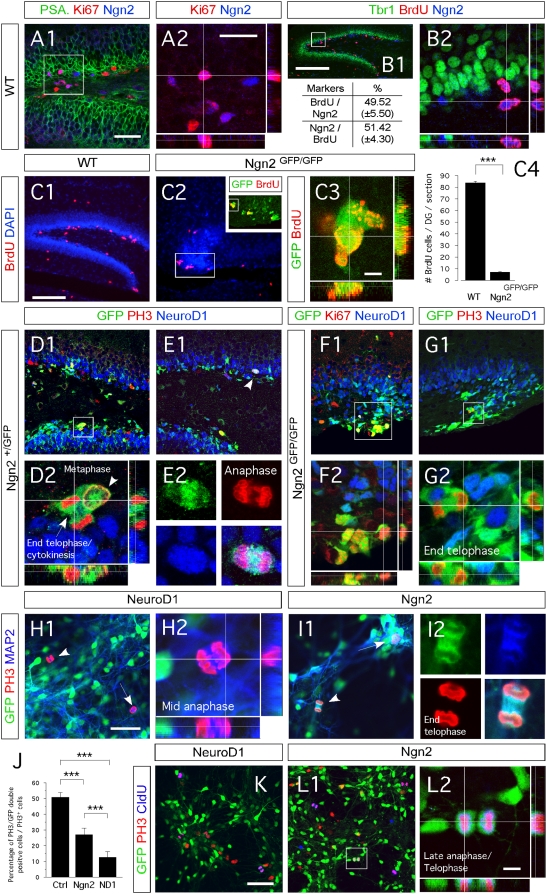
Ngn2 and NeuroD1 mark the initiation and end of amplification of hippocampal DG granule neuroblasts, respectively.(A1–C3 and D1–K2) Indirect immunofluorescence performed on hippocampal coronal sections from postnatal two-weeks old WT, Ngn2+/GFP and Ngn2GFP/GFP mutant animals and Ngn2 and NeuroD1 retrovirally transduced E14.5 cortico-hippocampal neurospheres. (A1 and A2) Fifty percent of Ngn2+ cells co-label with Ki67. (B1 and B2) One BrdU injection with a two-hour chase labels 50% of the Ngn2-expressing cell population, representing half of the total number of proliferating cells in the DG. (C1–C4) In the DG of two-weeks old Ngn2GFP/GFP mutant animals, the number of dividing cells is substantially decreased compared to WT (data expressed as ±SEM; *** P<0.0001). (D1 and D2) In Ngn2+/GFP mice, GFP/Ngn2-expressing cells undergo division and give rise to GFP+/NeuroD1− cells. These cells have a baso-apical orientation. (E1 and E2) GFP/Ngn2-expressing cells stop dividing when NeuroD1 expression starts. Dividing cells expressing GFP and NeuroD1 have a planar orientation (see also supplementary figure 4). (F1 and G2) All cells brightly GFP present in the ventral blade of the DG of Ngn2GFP/GFP mutant animals co-express Ki67; however, only very few divide, indicating that in absence of Ngn2, Ngn2 progenies stay arrested in the cell cycle. (H1–J) Presence of GFP+/MAP2+/PH3+ dividing neuroblasts in Ngn2-transduced E14.5 hippocampo-cortical neurospheres compared to NeuroD1-transduced cultures. (K–L2) Five days differentiated Ngn2 transduced cells (GFP+) that have been cultures for two more additional days in medium supplemented with CldU, are still capable of dividing after 7 days, as opposed to NeuroD1 transduced cells. Rectangular images on the bottom and right of the panels A2, B2, C3, D2, F2, G2, I1 and J1 represent a projection of 14-Z stacks images (total of 10–14 µm thick) from framed areas or pointing arrows in panels A1, B2, C3, D2, F2, G2, I1 and J1, respectively. The white crosshairs in these panels were positioned to show co-expression in single cells of markers of interest, as labeled above each panel. Arrows and arrowheads point at cells of interest. Scale bars: 100 µm (B1, C1 and C2), 50 µm (A1, D1, E1, F1, G1, H1, I1, K and L1), 25 µm (A2, B2, and F2), 10 µm (L2), 5 µm (C3, E2, G2, H2 and I2).